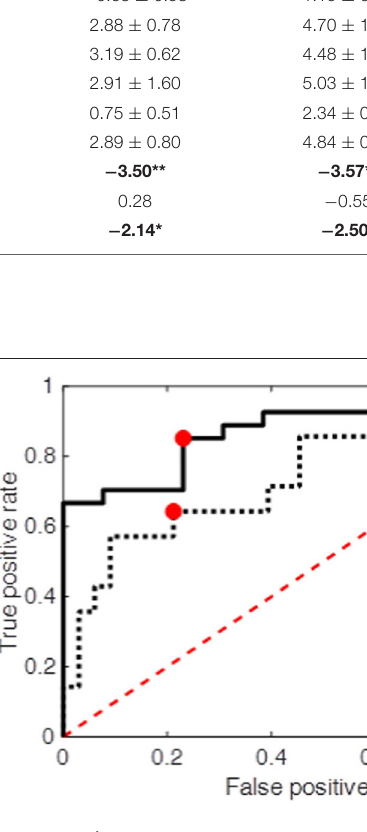
cognitive decline (Schanke and Sundet, 2000; Charlton et